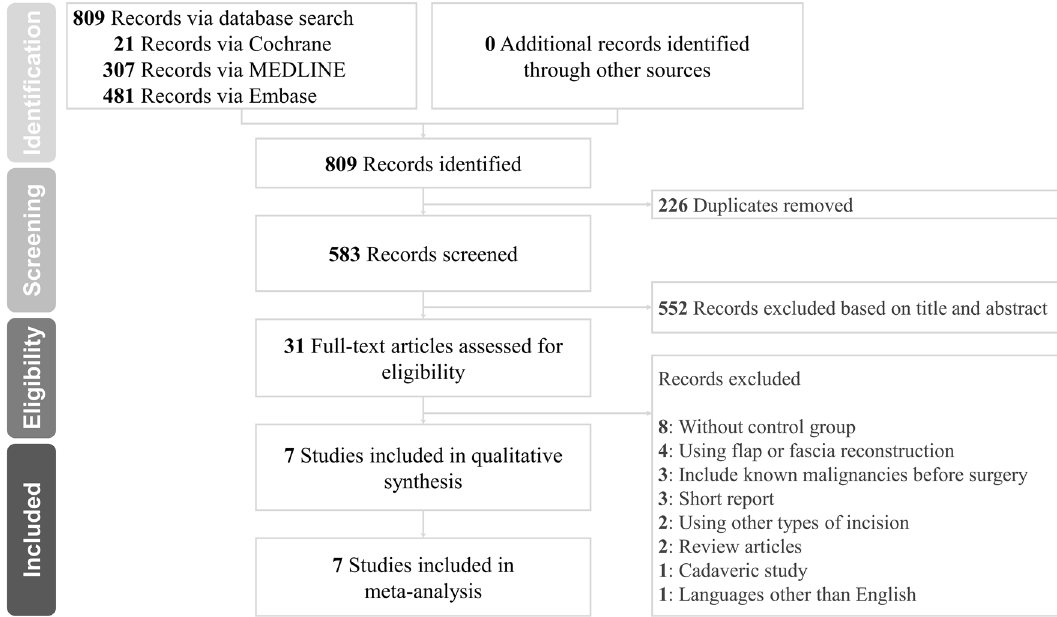
Figure 1. Flow diagram of the literature search.